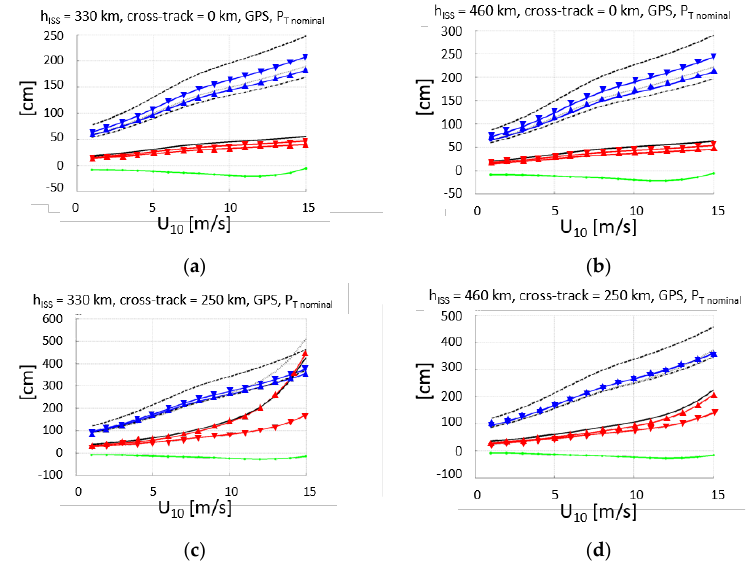
Figure 13. GPS constellation (nominal transmitted power [19], T i = 1 s): predicted GEROS-ISS altimetry rms error (black), rms error at L1 (red) and L5 (blue), and total bias: electromagnetic bias and waveform bias (green), for h ISS = 330 km ( a ) and ( c ) and 460 km ( b ) and ( d ), and for cross-track distance 0 km ( a ) and ( b ) and 250 km ( c ) and ( d ). Code: - ∆ - σ iF1 , - ∇ - σ iF5 , - ∆ - σ cF1 , - ∇ - σ cF5 , — σ iF1+iF5 , - - - σ cF1+cF5 , ·····